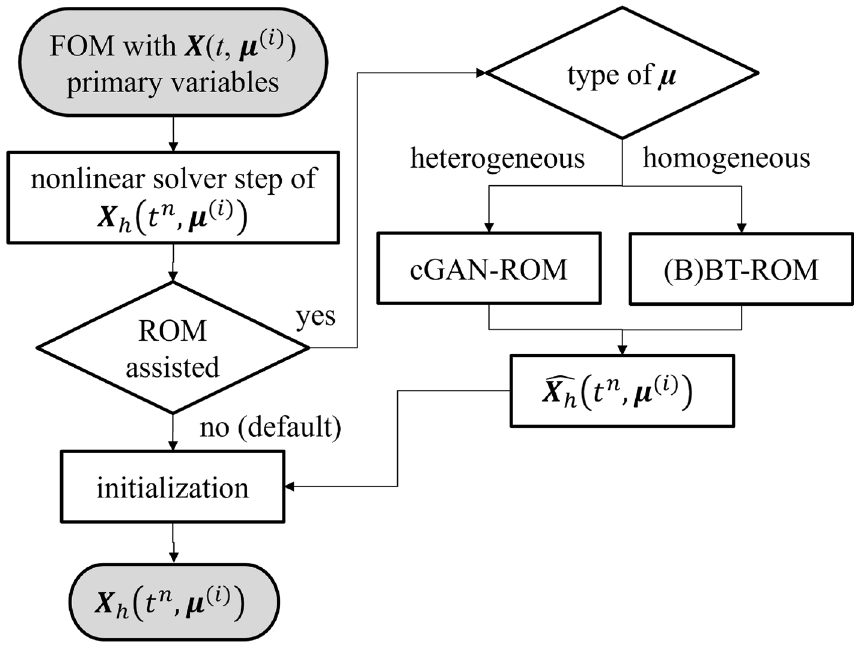
Figure 1. FOM nonlinear solver with ROM assisted procedures. We note that X is an exact solution, X h is quantities of interest obtaining from FOM, and parameterized parameters, which could be homogeneous or heterogeneous